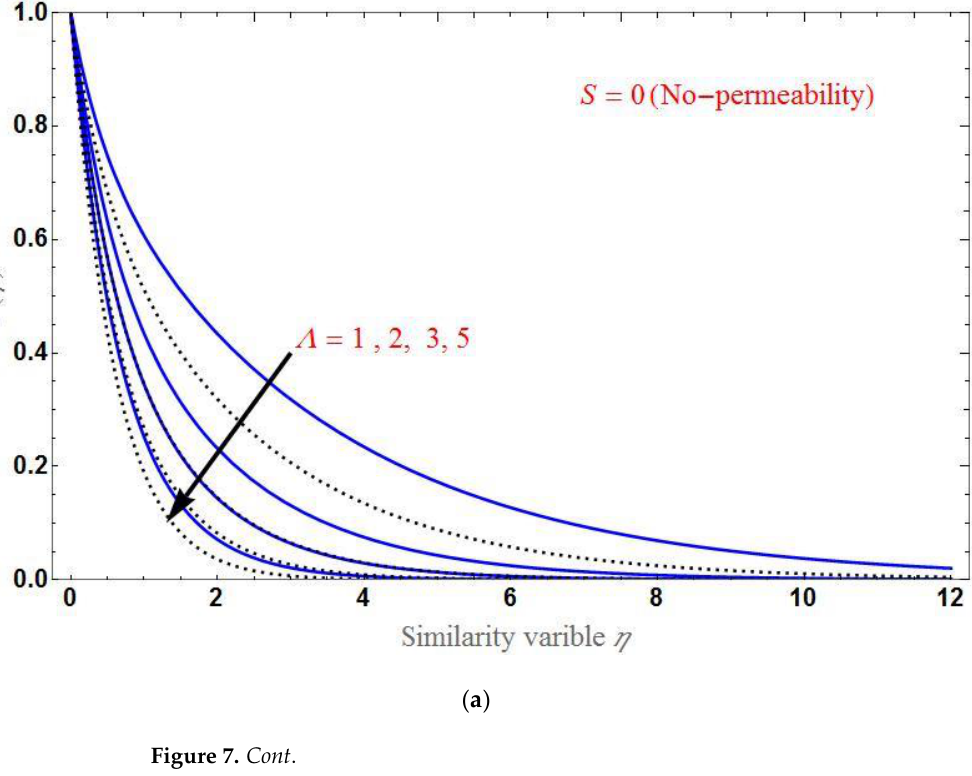
temperature distribution.